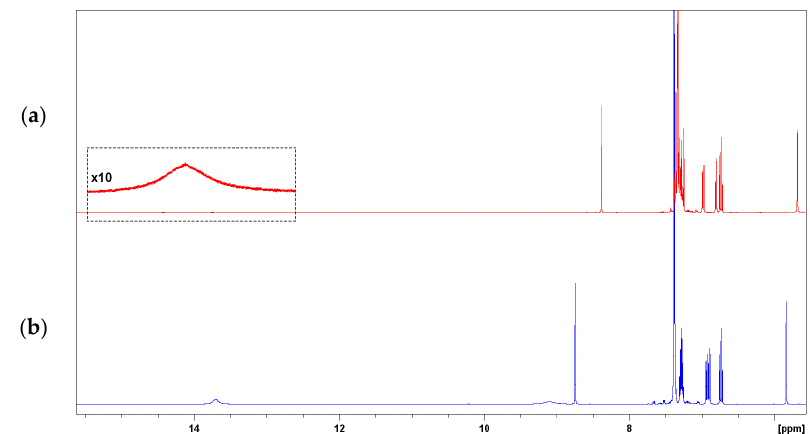
Figure D1. 1 H-NMR spectra of oOHsaladpm in ( a ) CDCl 3 and ( b ) DMSO-d 6 .